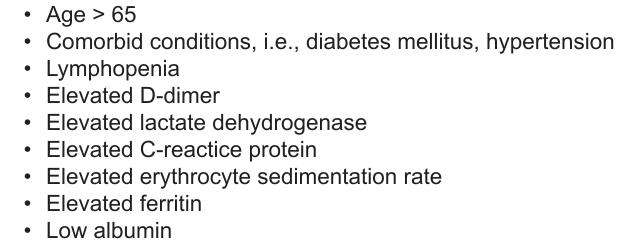
Table. Factors identified with morbidity and mortality in novel coronavirus disease 2019 patients.